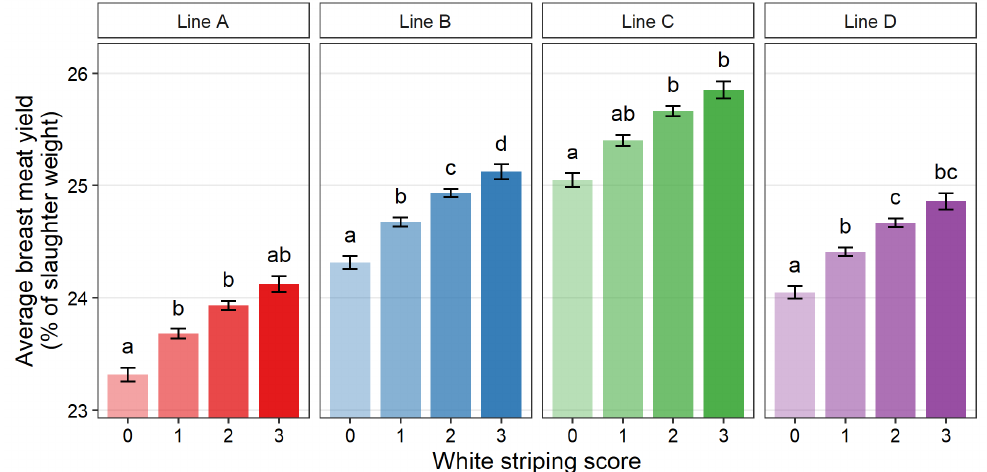
Figure 5. Least square means for breast meat yield (breast meat weight as a percentage of slaughter weight) of purebred turkey toms for each white striping score (0–3) within each genetic line (A: n = 2827, B: n = 3666, C: n = 2028, D: n = 3647). Error bars show standard error. Means with different letters (a–d) within genetic line represent statistical significance ( p < 0.05) as determined by Tukey’s HSD test.